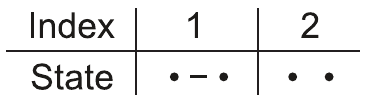
Figure 2. States for the single species system. For a single species we have two nucleotides, one left and one right, and these can either be linked or unlinked.